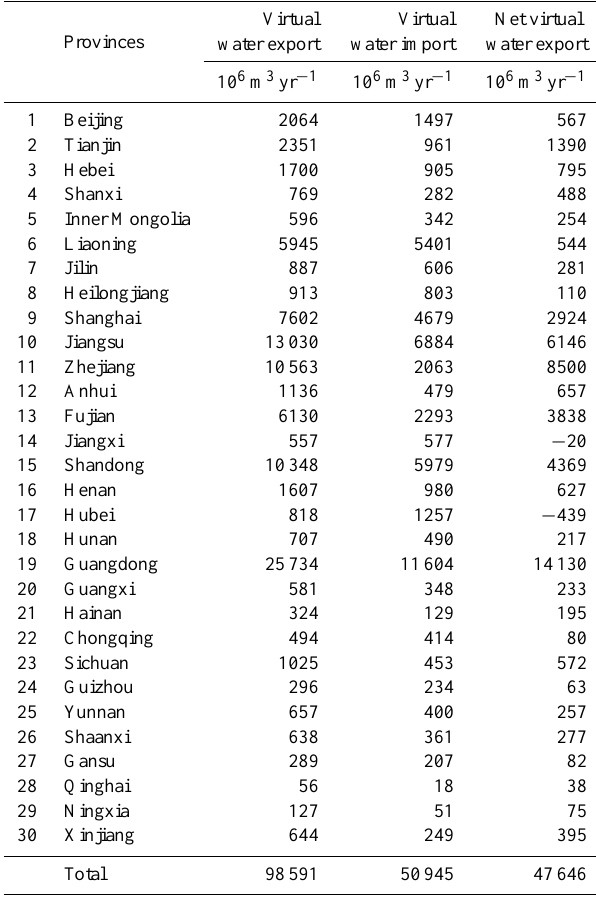
Virtual water trade at the provincial level (2002) (10 6 m 3 yr − 1 ).